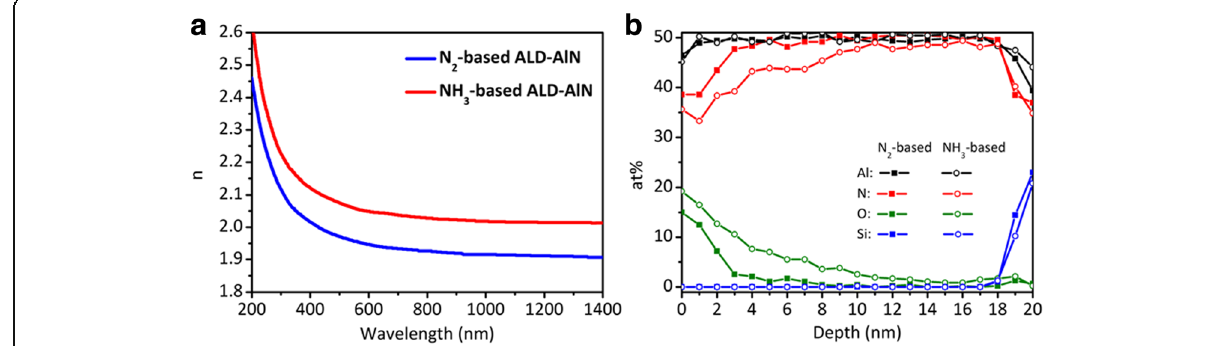
Fig. 2 a Refractive index as a function of the wavelength. b XPS depth profiles of the AlN films grown by N 2 ( closed square ) and NH 3 ( open circle ) ambient plasma. The ALD-AlN was grown on Si(100)